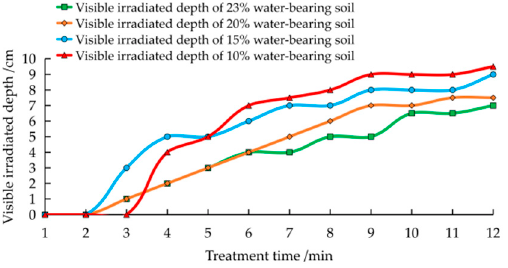
Figure 34. Visible drying depth of North China loess.